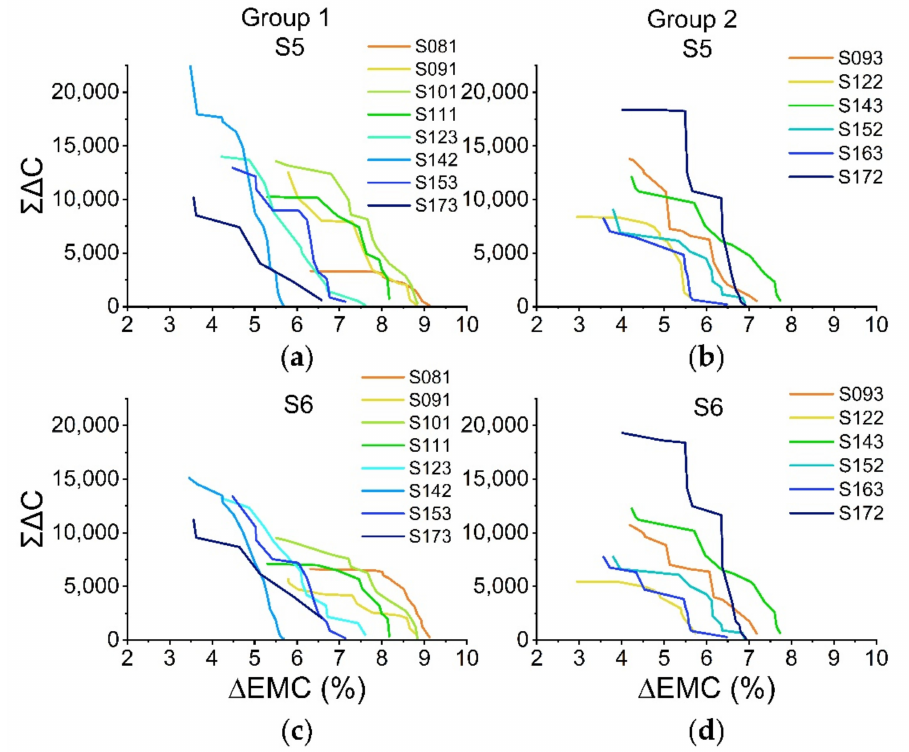
Figure 15. Σ∆ C vs. ∆ EMC (%). ( a ) Group 1, S5; ( b ) Group 2, S5; ( c ) Group 1, S6; and ( d ) Group 2,